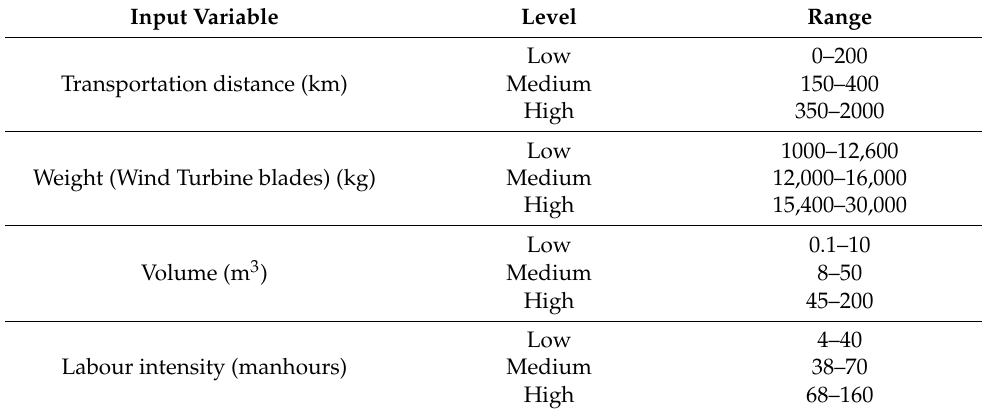
Table 1. Membership functions of input variables for transportation and dismantling cost.